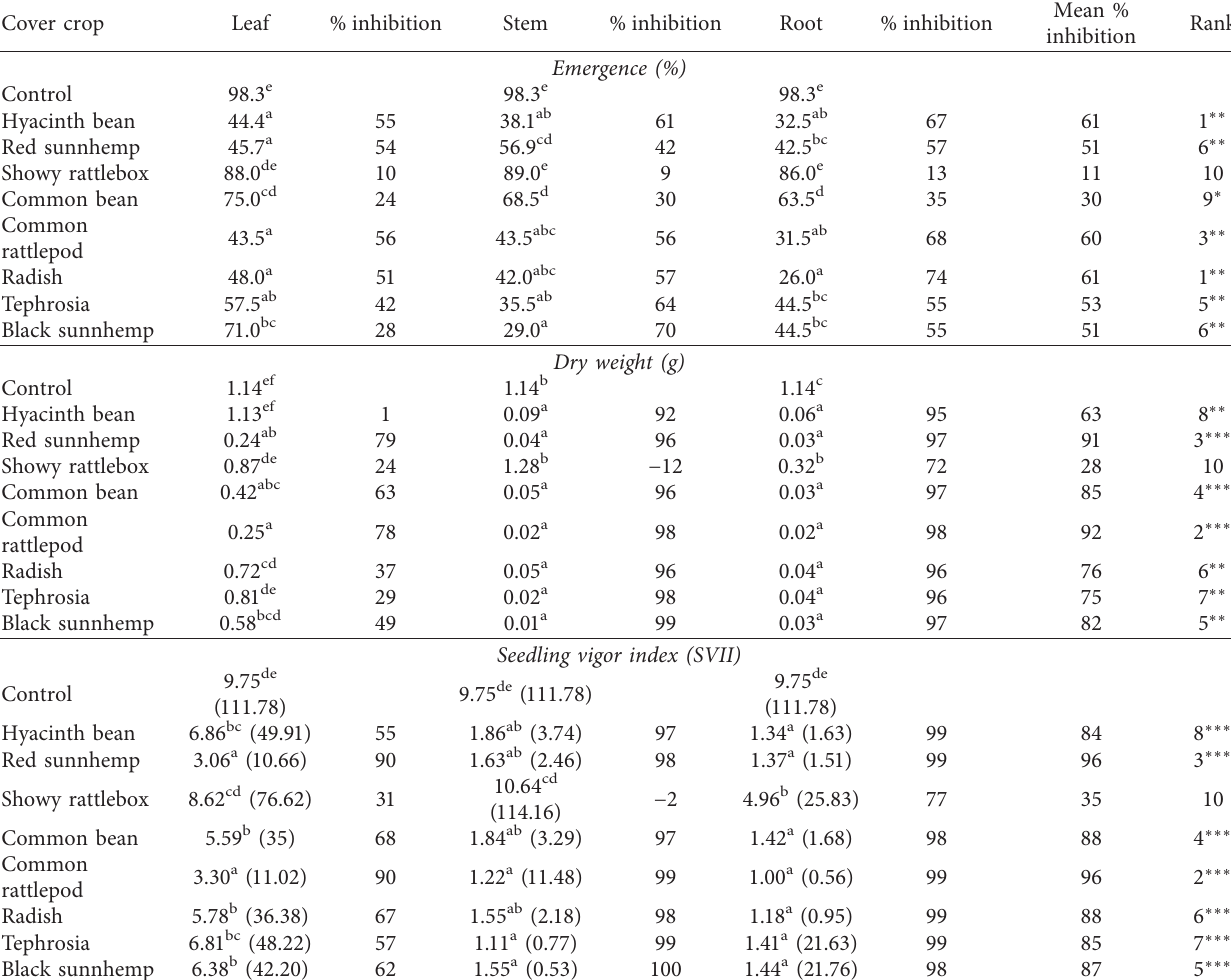
Table 8: Effect of soil-incorporated biomass of different plant parts of cover crops on the emergence of goose grass. Cover crop